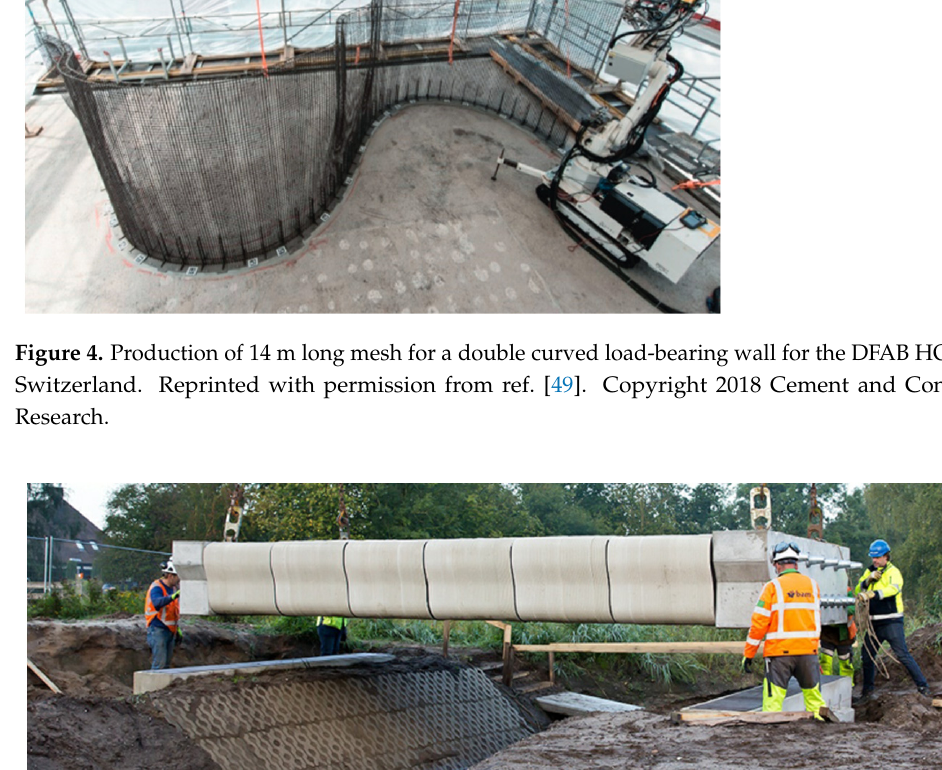
Figure 5. The 3D concrete printed pedestrian and bicycle bridge in Gemert, the Netherlands, is hoisted into position. Reprinted with permission from ref. [3]. Copyright 2018 Cement and Concrete Research.